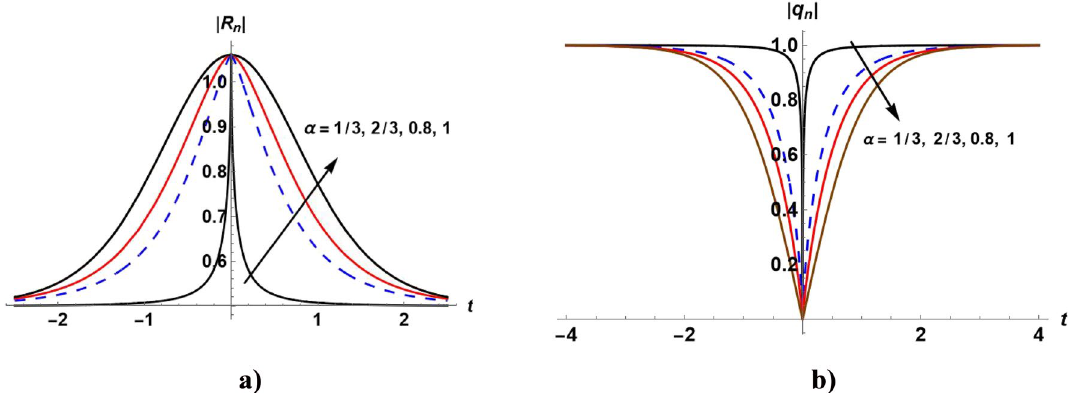
tanh η , α 4 2, α 2 0, , β 1 and even values of n for = = = =